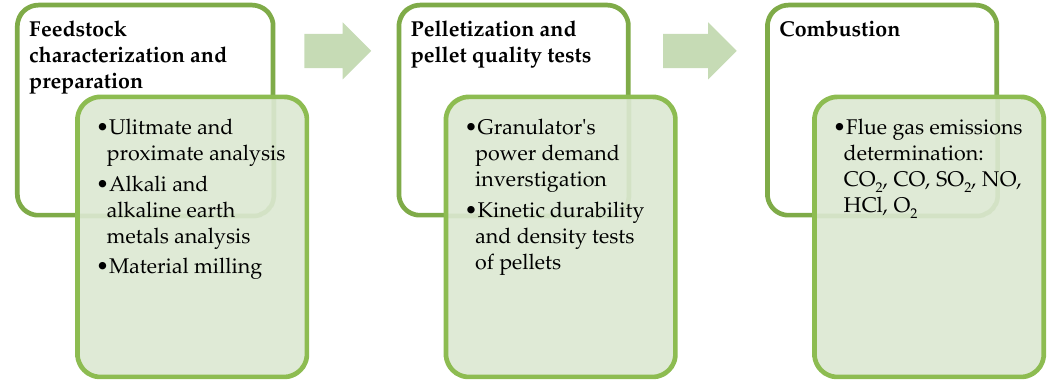
Figure 1 . Schematic plan of the research . Figure 1. Schematic plan of the